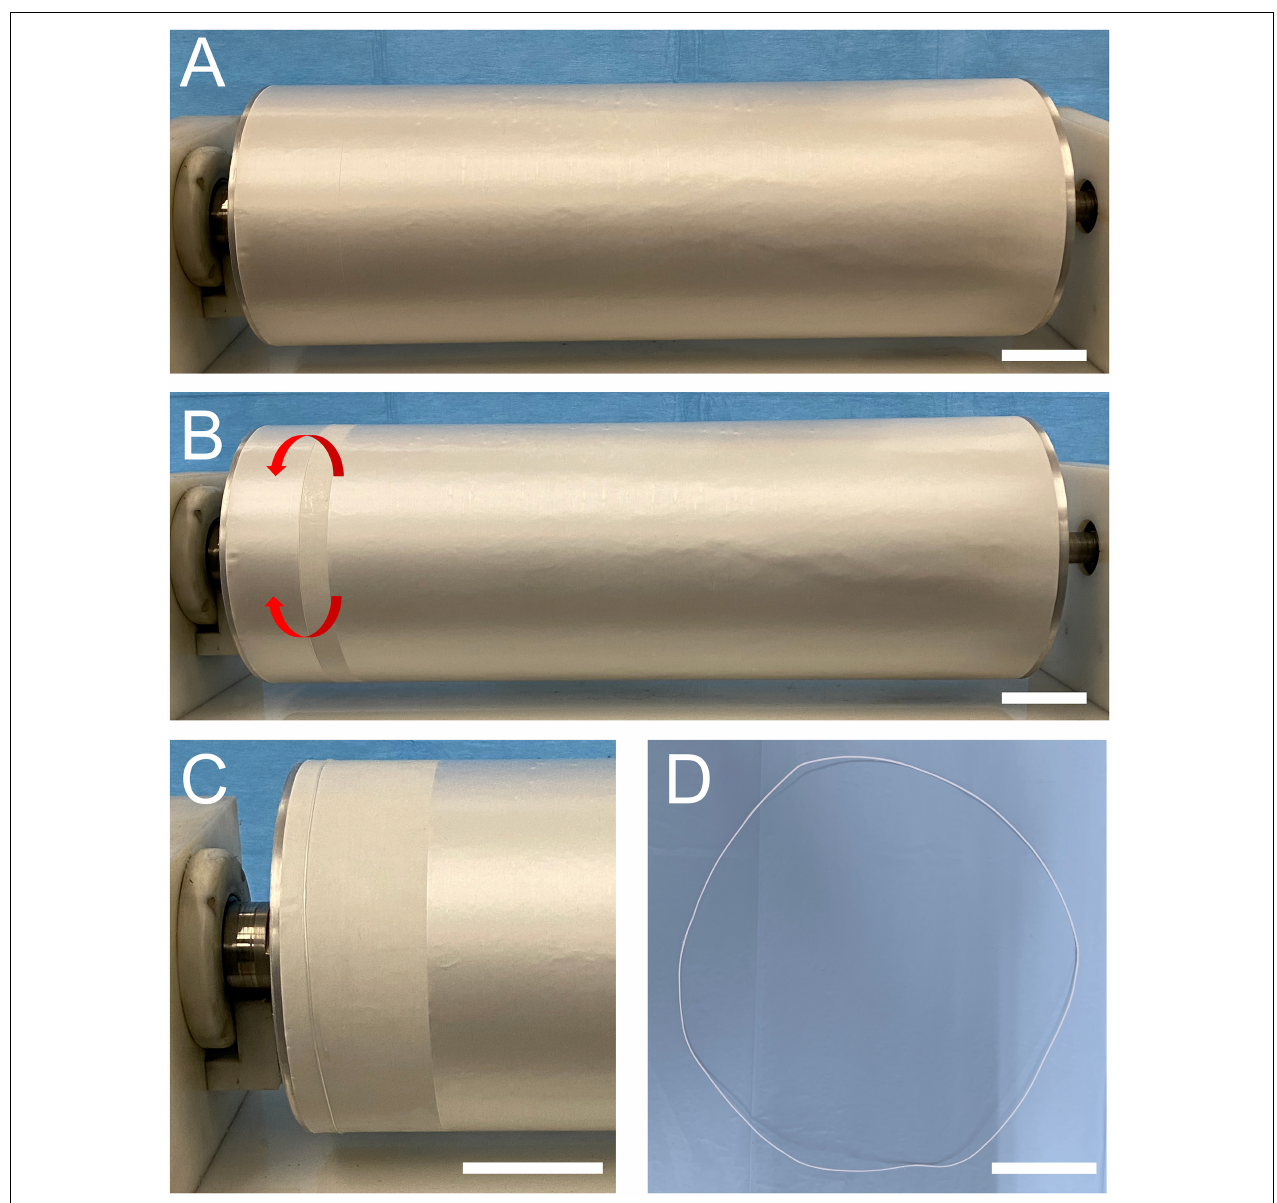
FIGURE 2 | Series of images showing the procedure for a ring-shaped bundle preparation: (A) mat of nanofibers electrospun on the rotating drum collector; (B) a stripe of the mat that was wrapped up on the drum; (C) the ring-shaped bundle just wrapped on the drum is visible on the left, while the rest of the mat, ready for being wrapped, is still on the right; and (D) ring-shaped bundle pulled off the drum (scale bars = 50